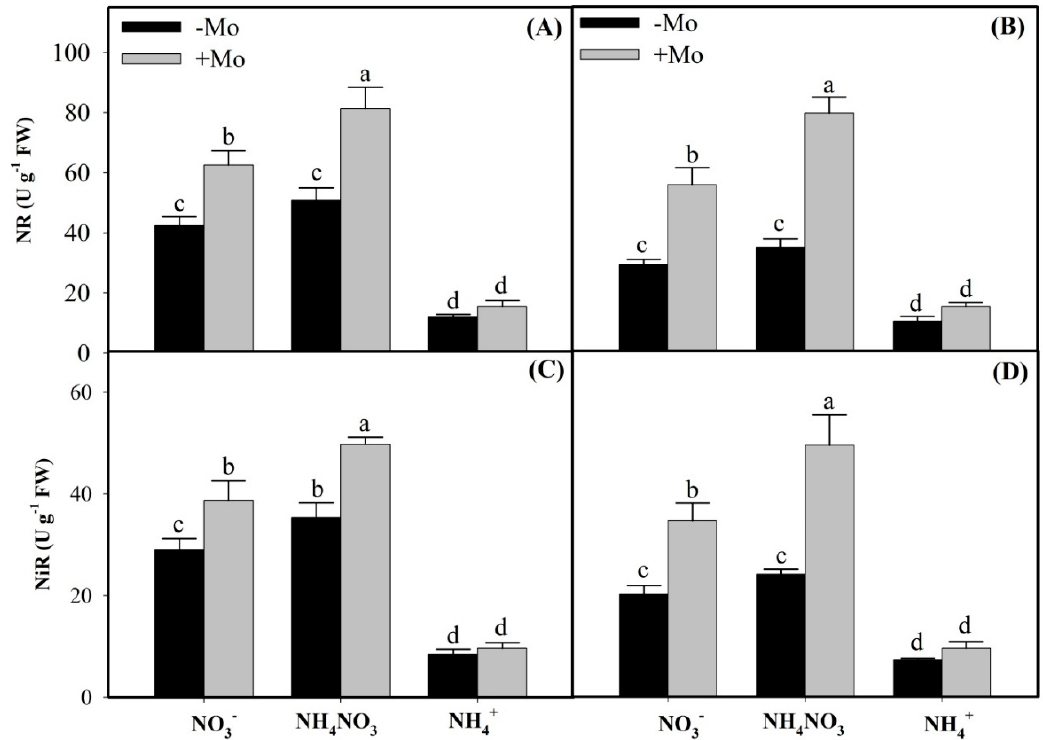
Figure 1. Impacts of Molybdenum (Mo) application on nitrate reductase (NR) and nitrite reductase (NiR) activities of Mo-efficient winter wheat ‘97003’ cultivar ( A , C ) and Mo-inefficient winter wheat ‘97014’ cultivar ( B , D ) under different N sources. − Mo and +Mo treatments represent the 0 and 1 µM Mo [Na 2 MoO 4 .2H 2 O] concentrations, respectively, in Hoagland solution. Vertical bar above indicates standard error of four replicates. Different lowercase letters (a, b, c, etc.) represent significant differences according to the least significant difference (LSD)-test ( p < 0.05, n = 4). NO 3 − : sole nitrate source, NH 4 NO 3 : co-applied ammonium nitrate, NH 4+ : sole ammonium source.